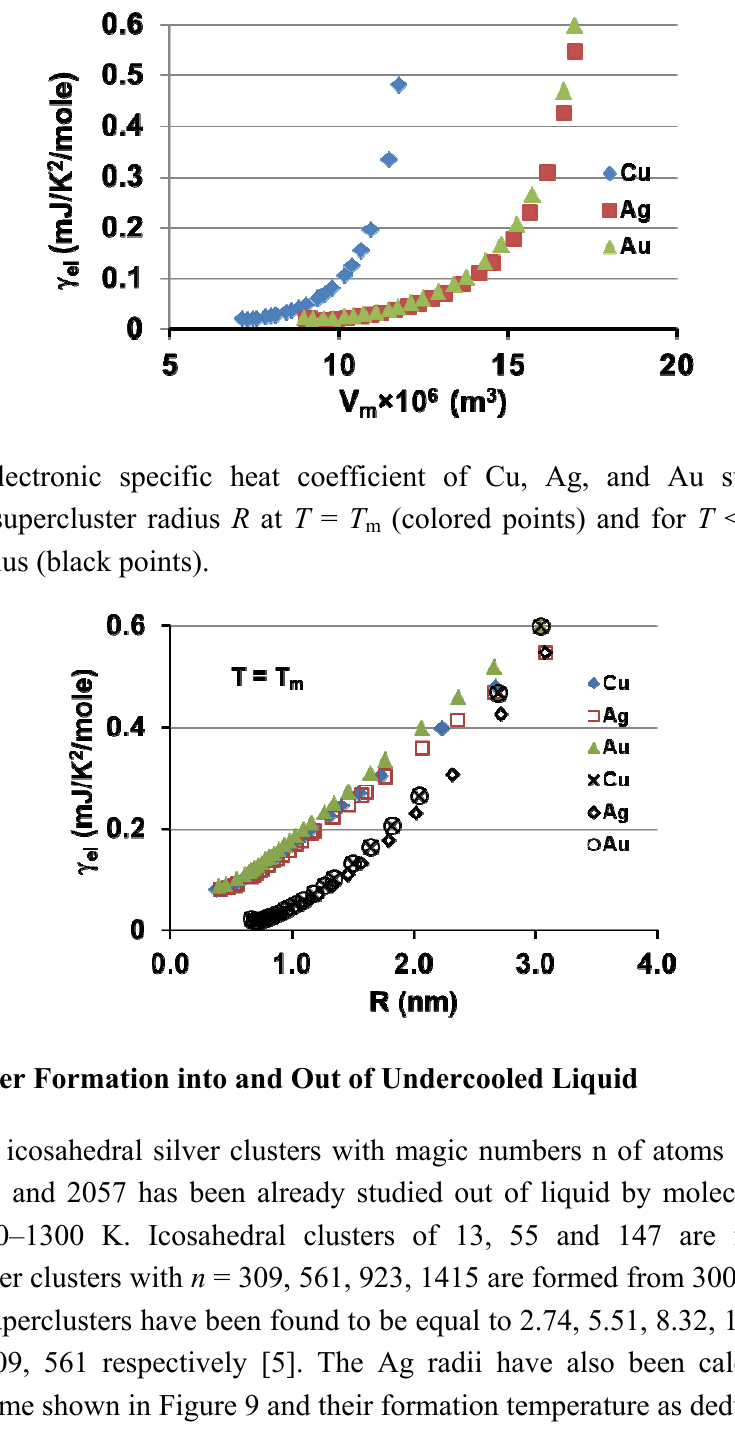
Figure 11. Electronic specific heat of superclusters. The supercluster electronic specific heat coefficient in mJ/K 2 /mole is plotted versus their molar volume in m 3 when the critical radius is smaller and smaller below T . m